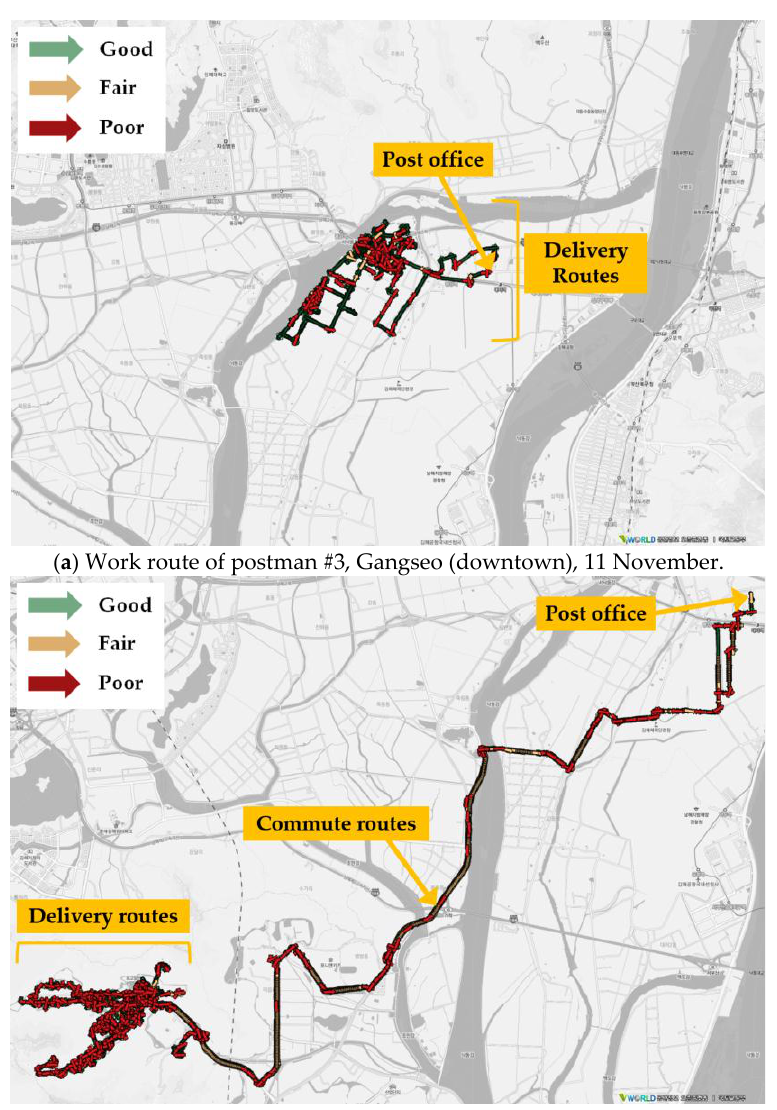
Figure 7. Distribution of safety index plotted on a work route (1:67,000), extracted from GPS data gathered by a system installed on a postman’s PDA in Gangseo: green for “Good”, yellow for “Fair”, red for “Poor”.